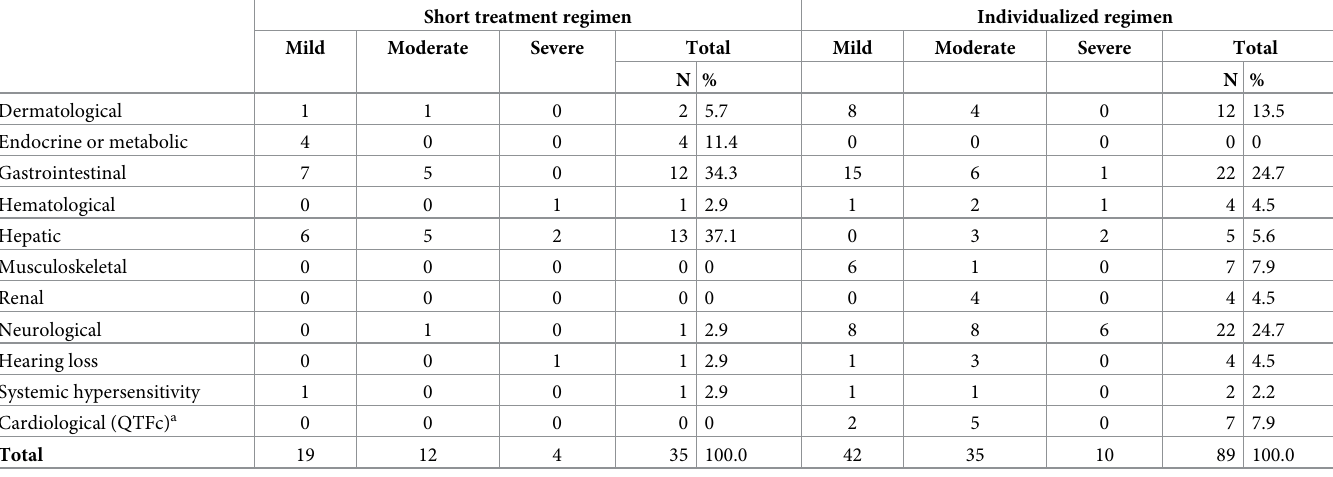
Table 5. Typology and grading of 124 reported adverse